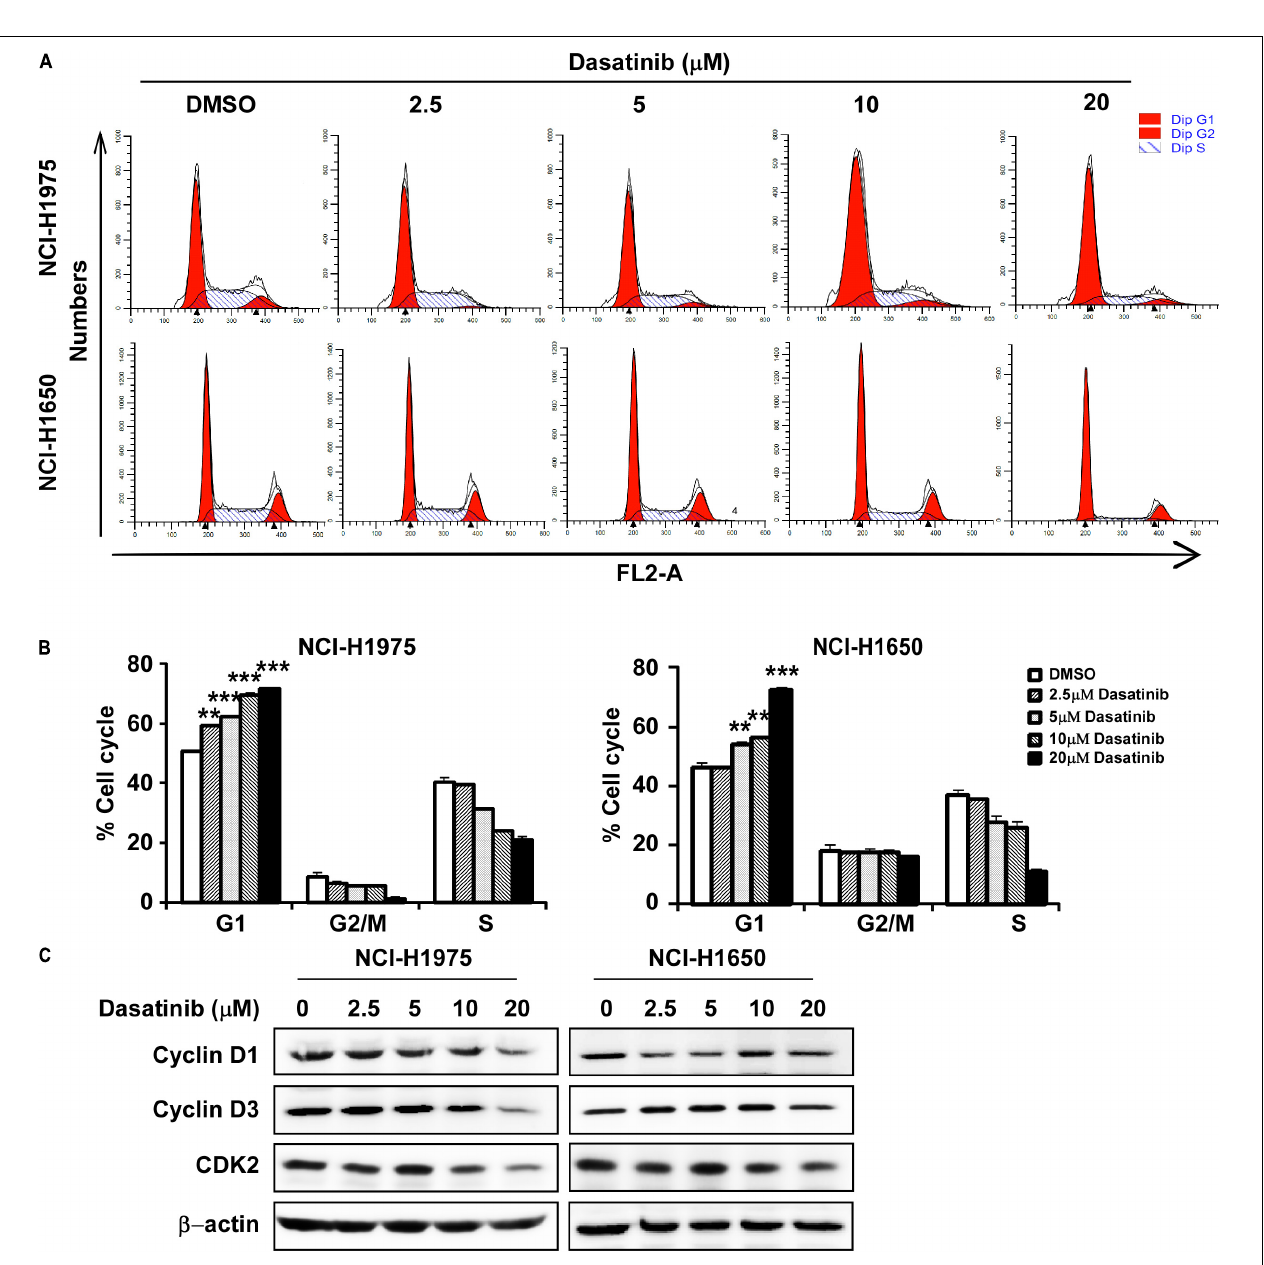
FIGURE 3 | Dasatinib induces cell cycle arrest at G1 phase (A) Dasatinib induced cell cycle arrest at G1 phase. (B) Dasatinib induces cell cycle arrest at G1 phase in a concentration dependent manner. (C) Western blotting results showed the decreased expression of cyclinD1, cyclinD3, and CDK2, G1 phase marker for cell cycle. The asterisks (* p < 0.05, ** p < 0.01, *** p < 0.001) indicated a significant difference between untreated control and dasatinib-treated cells. Data were shown as means ± SD of values from triplicate samples and similar results were obtained from three independent